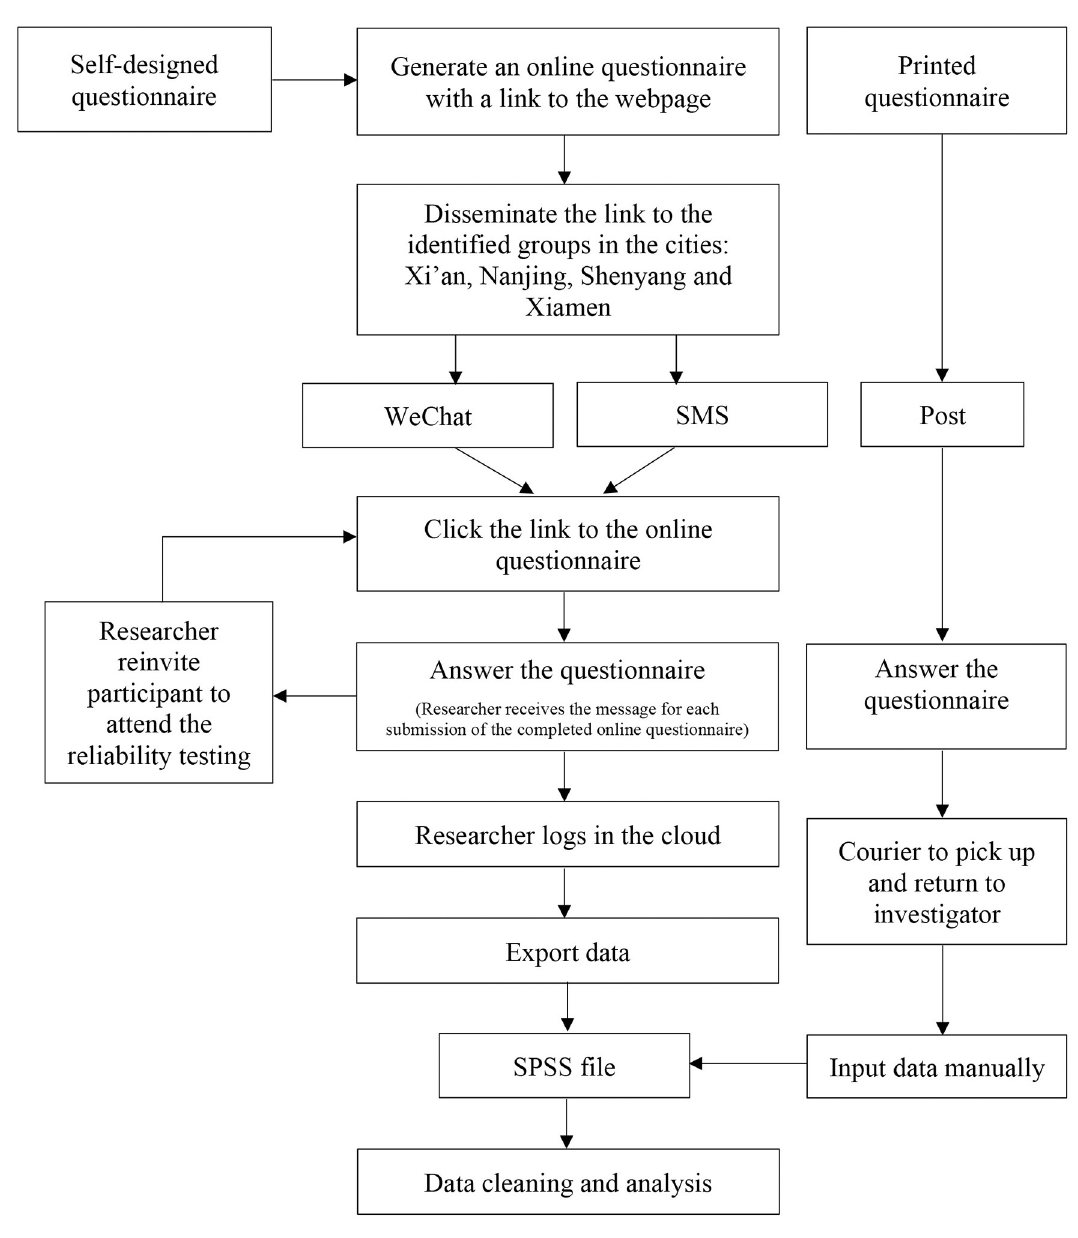
Fig 3. Data collection